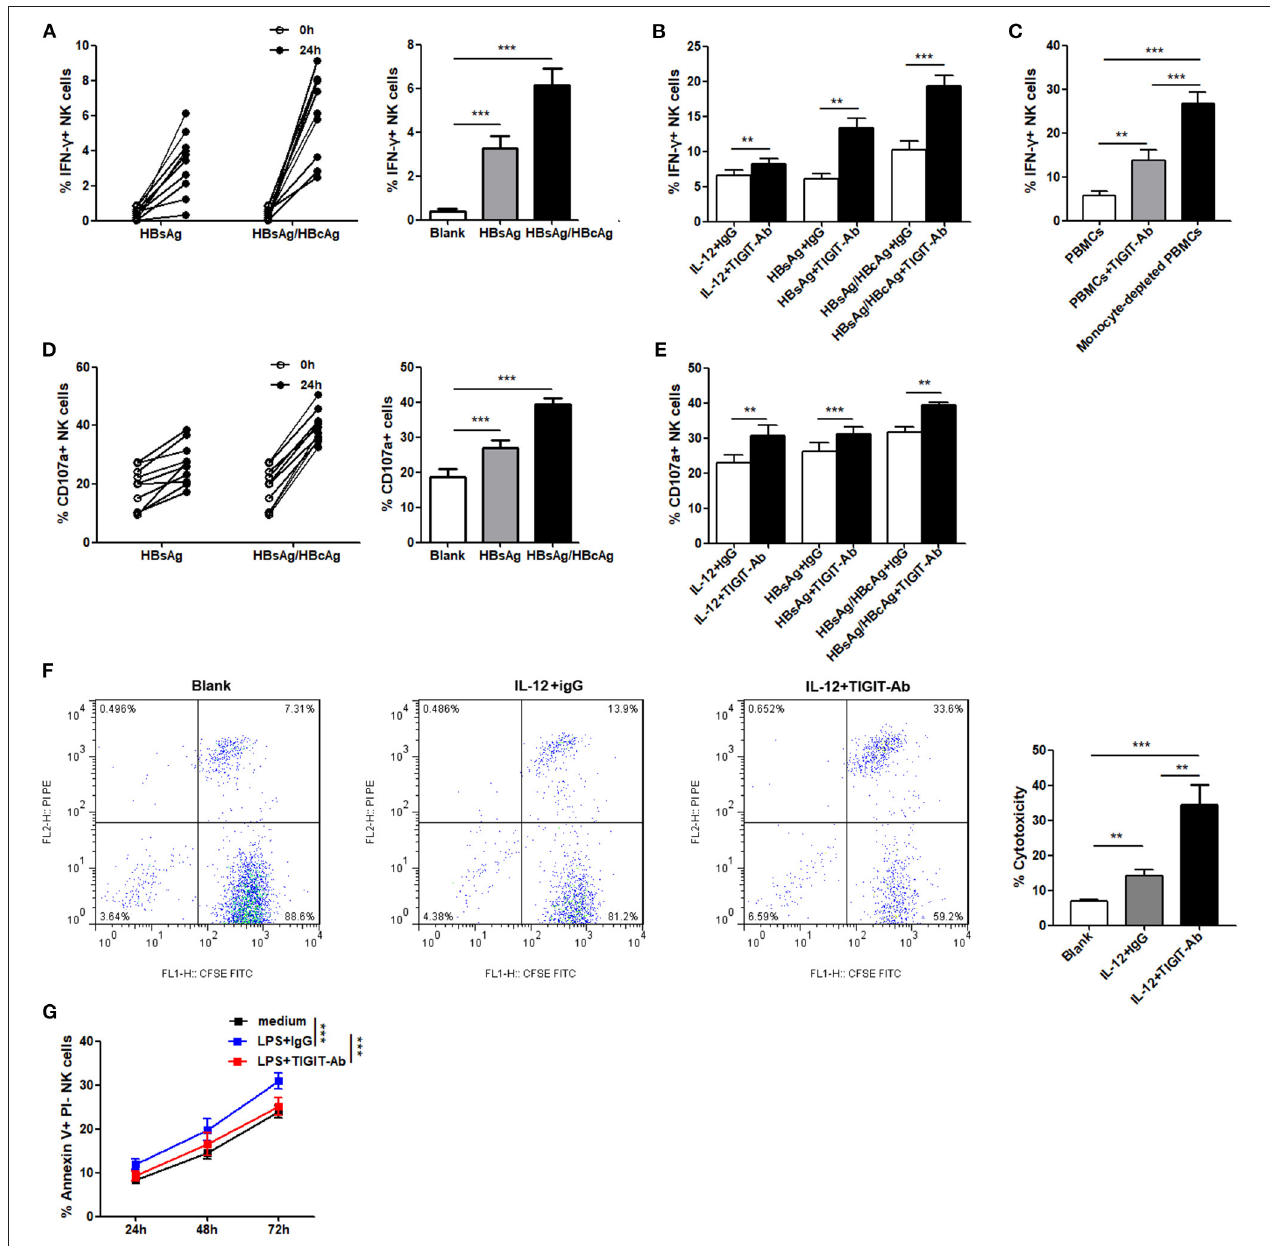
FIGURE 4 | Blockade of the TIGIT pathway affects NK-cell function in CHB-IA. (A,B,D–F) PBMCs isolated from CHB-IA were stimulated with IL-12 or specific stimulants (recombinant HBsAg protein or recombinant HBsAg and HBcAg protein mixture) in the (A,D) absence or (B,E) presence of TIGIT-Ab protein or IgG control for 24h. The percentages of (A,B) IFN- γ and (D,E) CD107a in NK cells before and after stimulation were evaluated by flow cytometry (n = 10). (C) PBMCs or monocyte-depleted PBMCs were stimulated with IL-12 for 24h. Representative FACS dot plots showing IFN- γ expression in NK cells from PBMCs or monocyte-depleted PBMCs (n = 10). (F) Purified NK cells stimulated with or without IL-12 in the absence or presence of TIGIT-Ab for 24h were collected as effector cells. K562 cells labeled with CFSE were used as target cells. E:T ratios was 1:10 for 6h. Representative FACS plots showing cytotoxicity of NK cells. The cytotoxicity of NK cells in CHB-IA was analyzed and shown as the mean ± SD (n = 5 subjects per group). (G) PBMCs isolated from CHB-IA were stimulated with LPS in the absence or presence of TIGIT-Ab for 24, 48, and 72h. The percentages of Annexin V + PI- NK cells was measured by flow cytometry. Data are shown as the mean ± SEM (n = 5). Data are from a single experiment representative of three. * p < 0.05, ** p < 0.01, *** p <